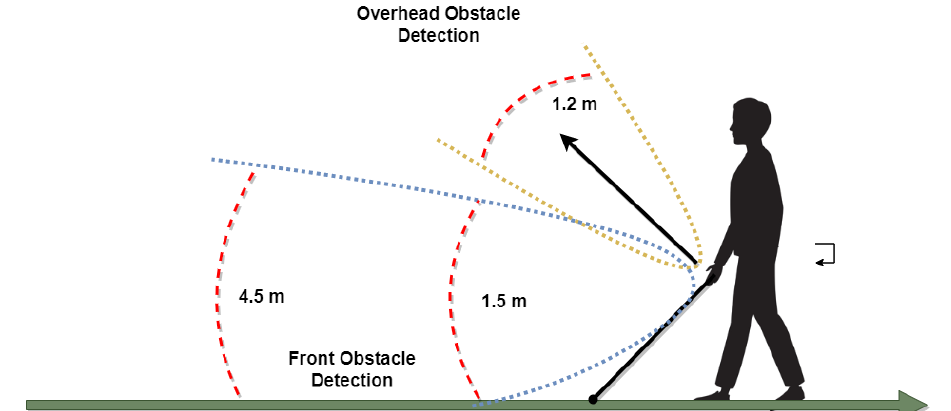
Figure 5. Ultrasonic sensors’ placement on the smart